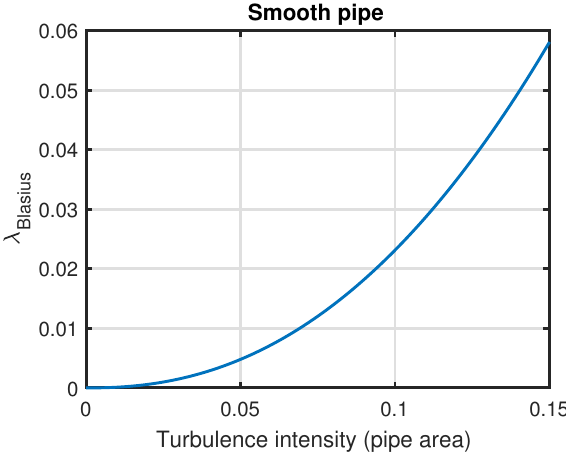
Figure 7. Relationship between pipe area turbulence intensity and the Blasius friction factor.